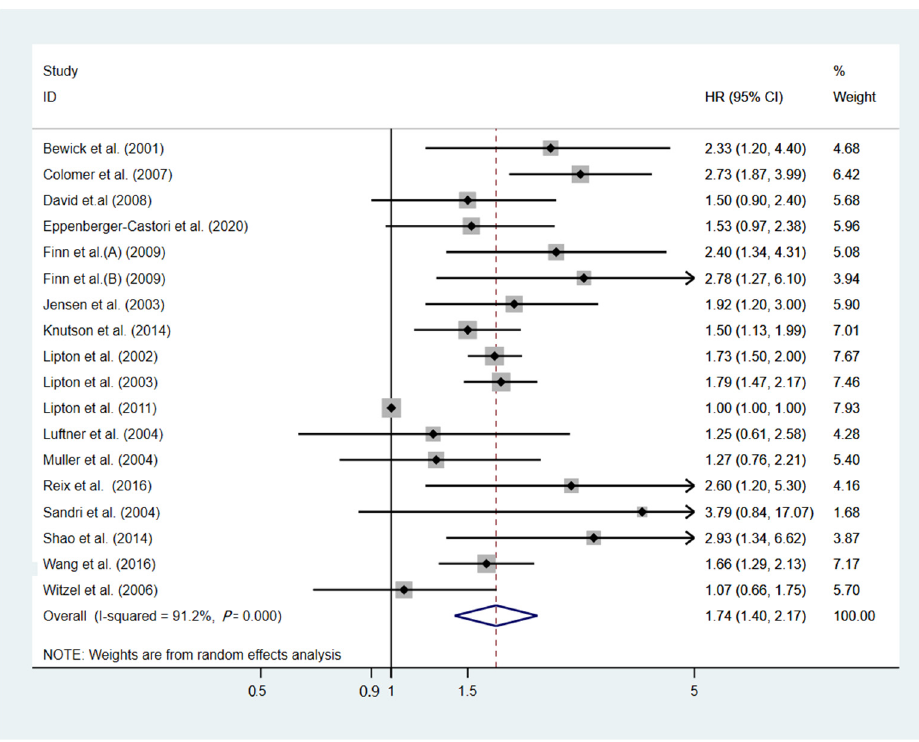
Figure 2. Forest plot of the HR for the PFS from the eligible studies [10,13,16,25,27,28,31–33,39,44,45,48,49,53,54,59].